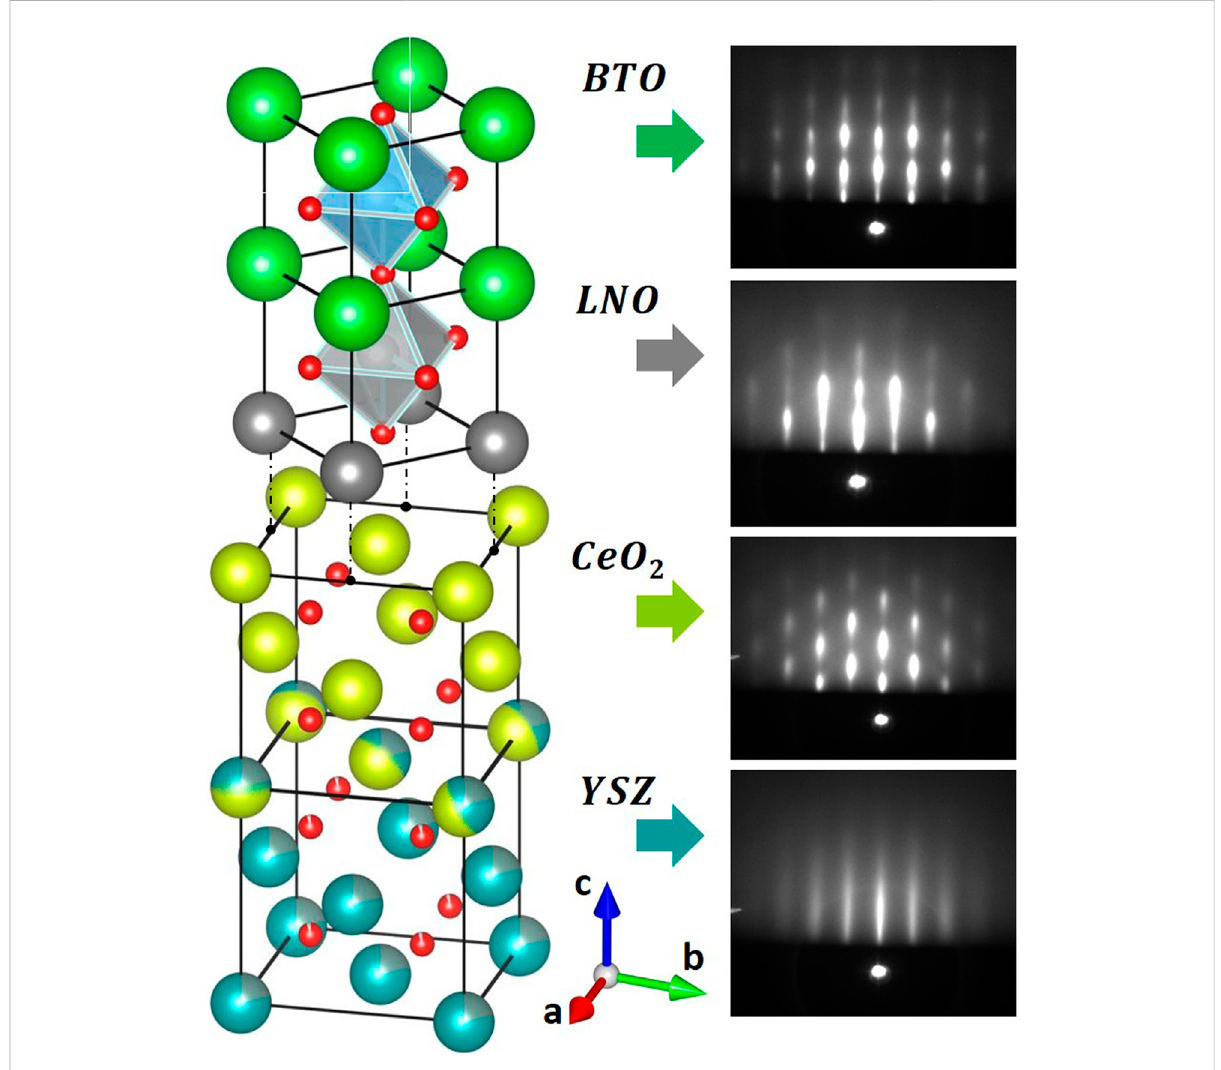
FIGURE 1 Sketch of the fabricated Si(001)/YSZ/CeO 2 /LaNiO 3 /BaTiO 3 heterostructure, displaying the epitaxial relations. On the right are displayed the corresponding RHEED patterns, obtained after the fi nalisation of the growth of each layer.